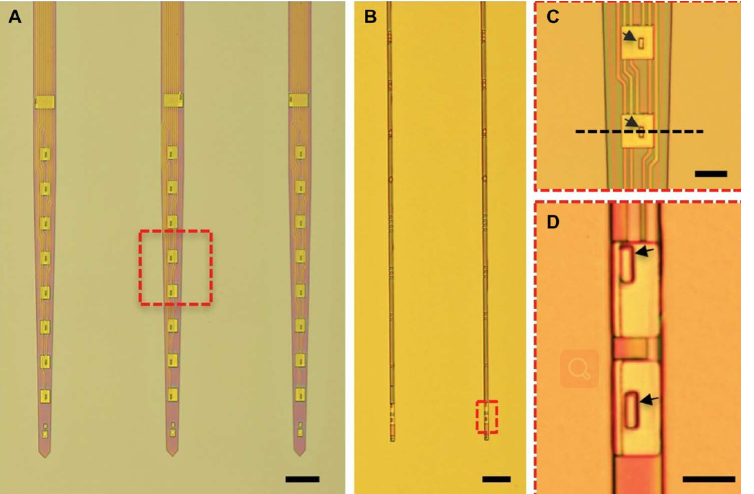
Figure 4. Nanoelectronic thread (NET) electrodes [18]: ( A ) as-fabricated NET-50 probes on substrates, ( B ) as-fabricated NET-10 probes on substrates, ( C ) zoom-in views of electrode as marked by the dashed boxes in ( A ), and ( D ) zoom-in views of electrode as marked by the dashed boxes in ( B ).